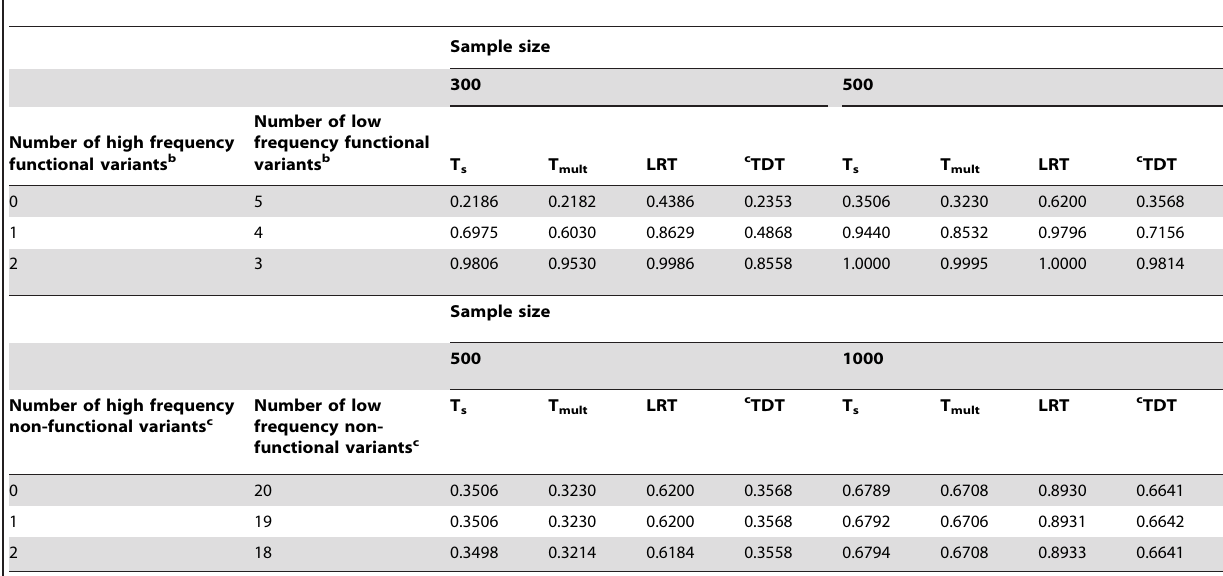
Table 4. The power of the tests when high frequency functional and nonfunctional variants were included a